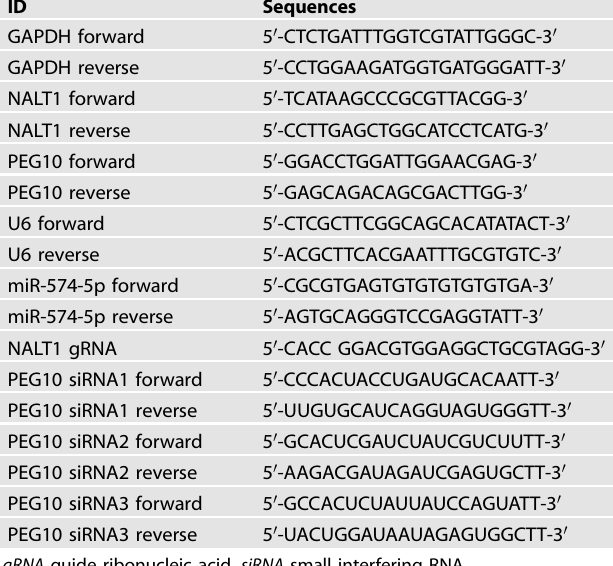
Table 2. Sequences used in this